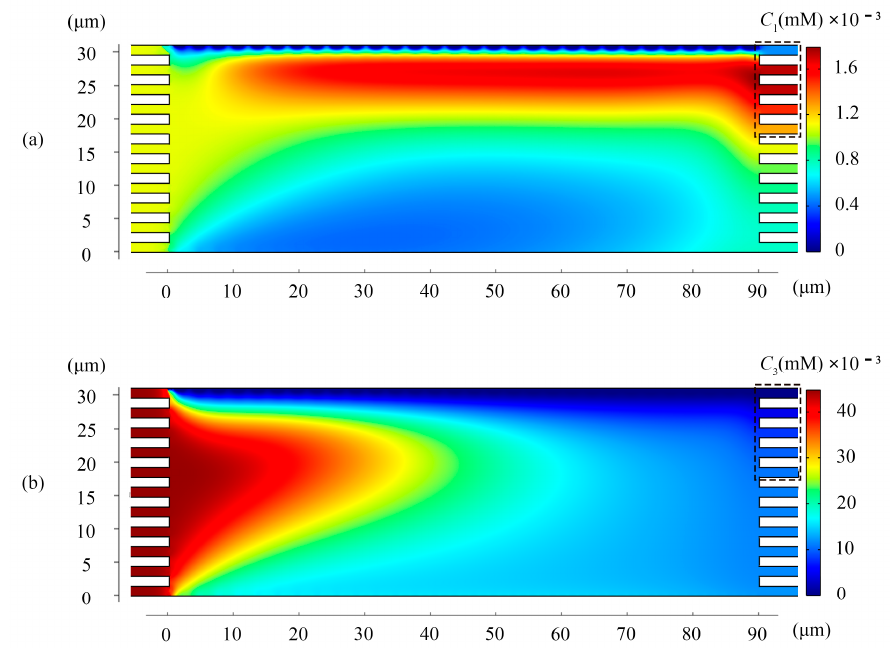
Figure 2. ( a ) The concentration distribution of Li + in the chamber ( b ) The concentration distribution of Mg 2+ in the chamber. Values of other parameters: V = 30V T , u out = 0.5 mm/s, u 1 = 0.63 mm/s, and u 2 = 1